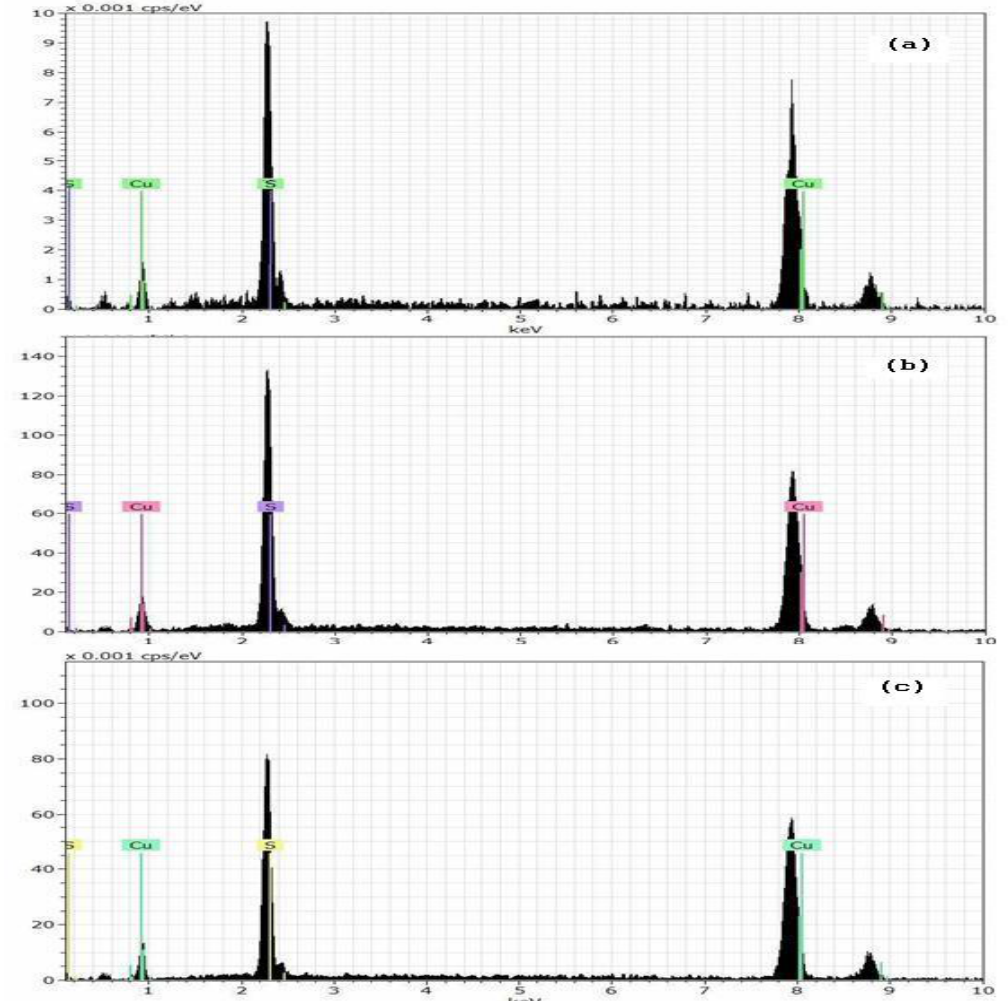
Fig. 1: EDS chart of Cu S powders at different ratios of Cu: a-x=1, b-x=0.25, 2-x